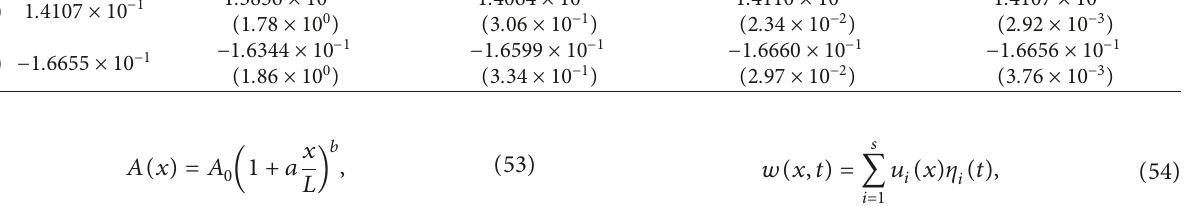
Table 7: The real parts of the exact and approximate natural frequencies for the perturbed whirling beam of Figure 11 for σ First-order Exact straightforward perturbation